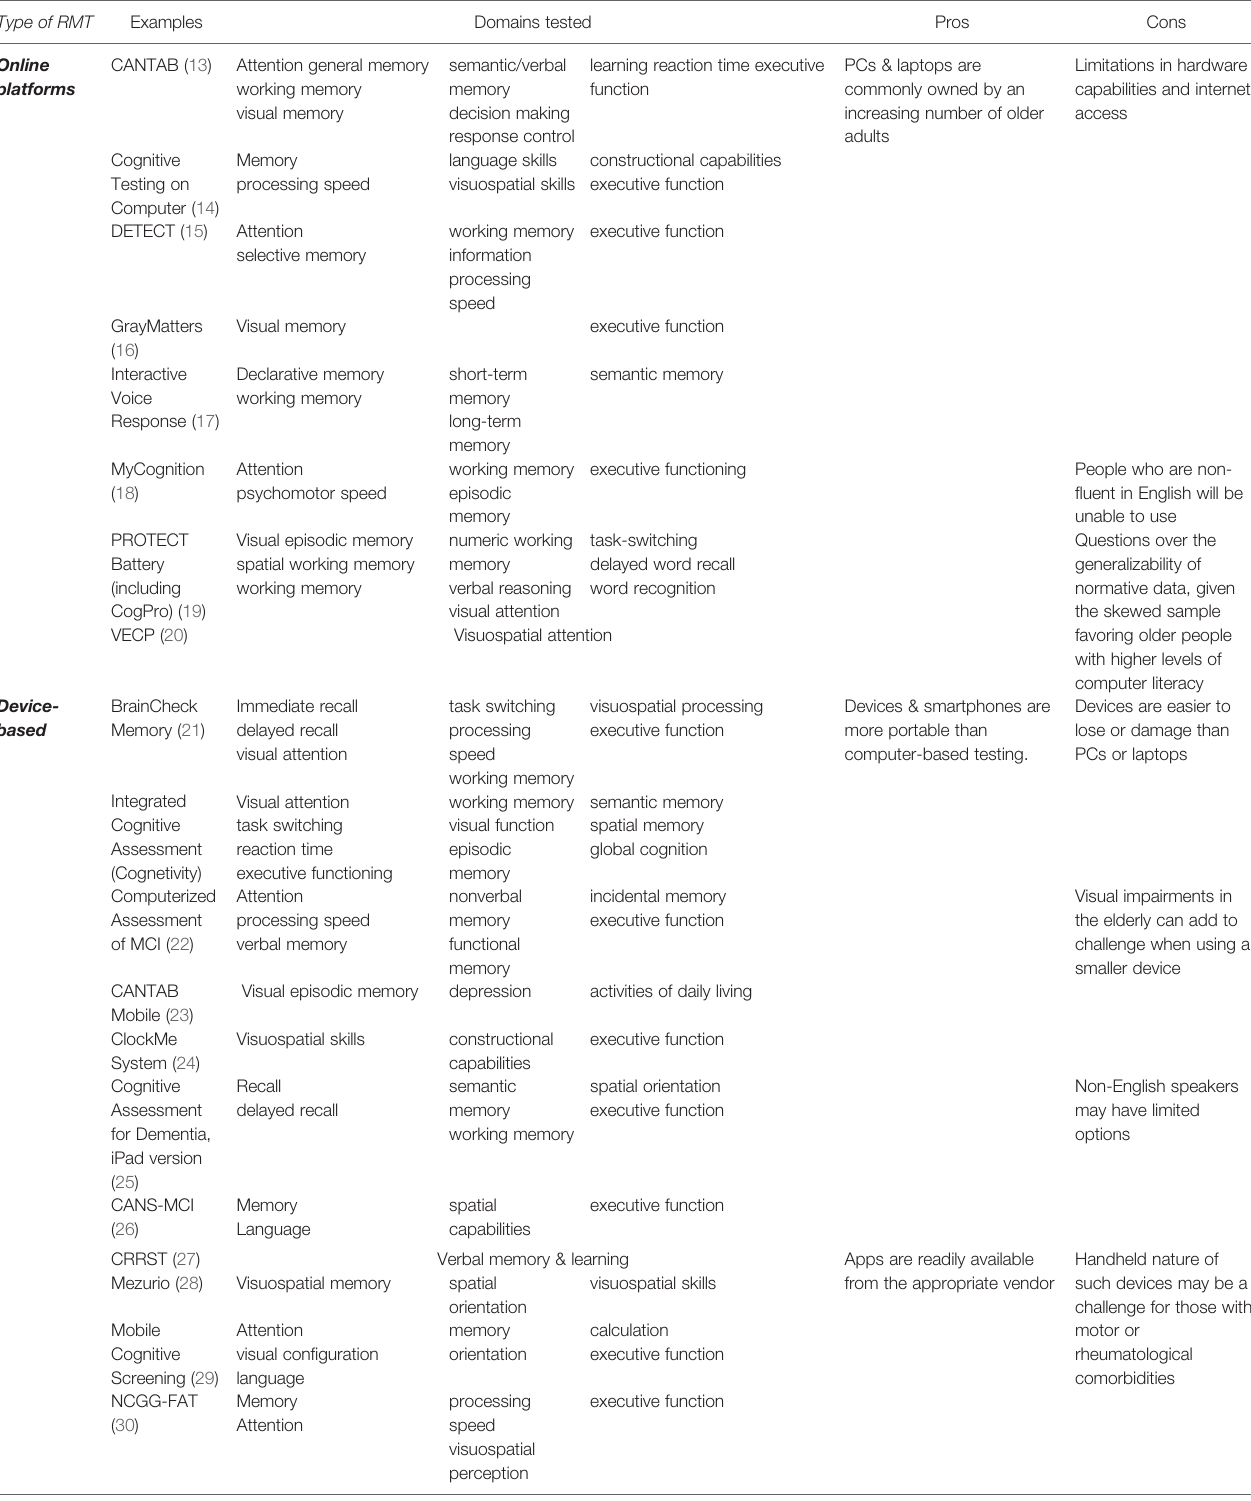
TABLE 2 | Potential remote measurement technologies for self-administered remote cognitive